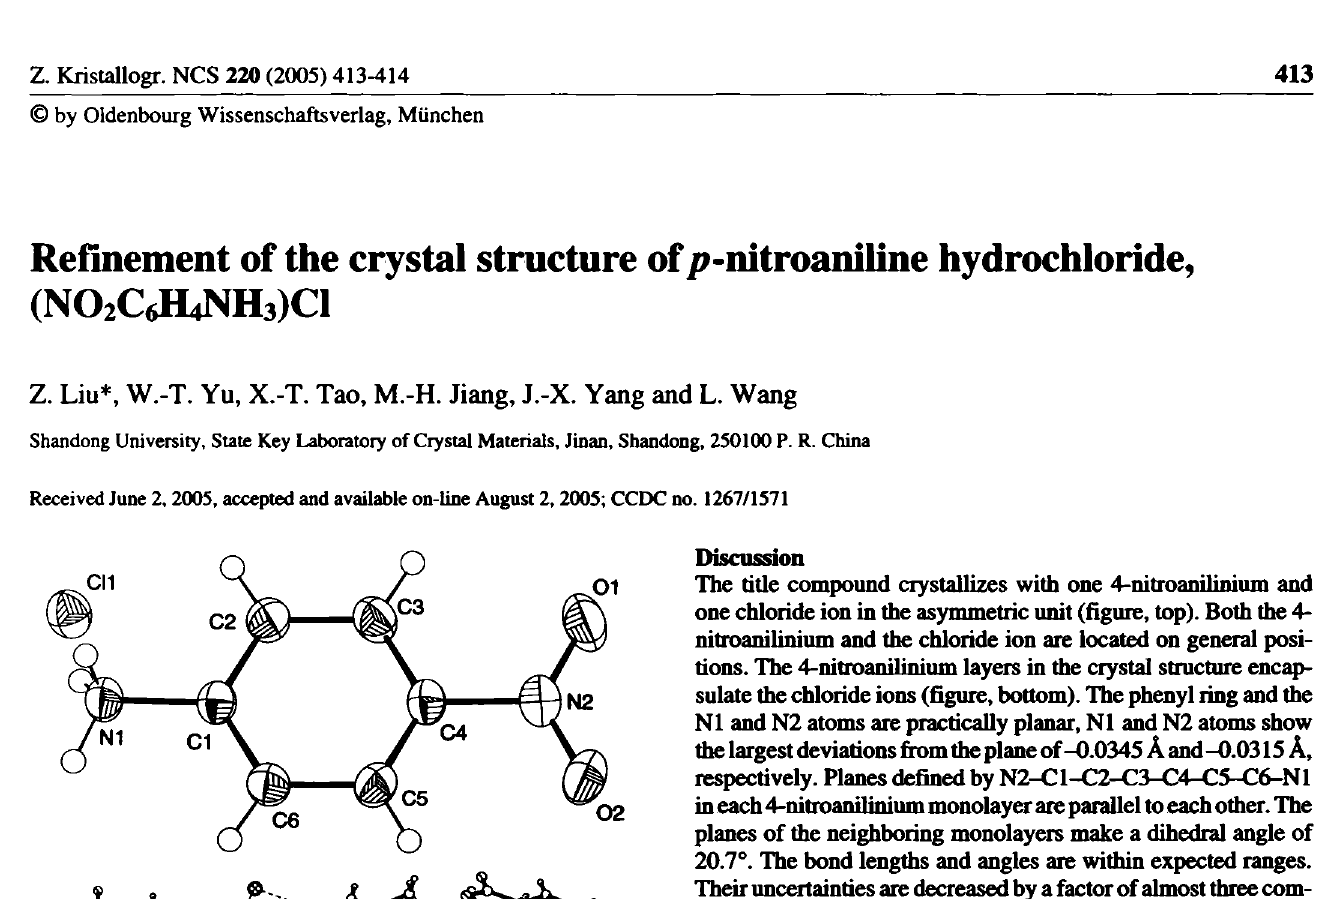
Table 1. Data collection and handling.